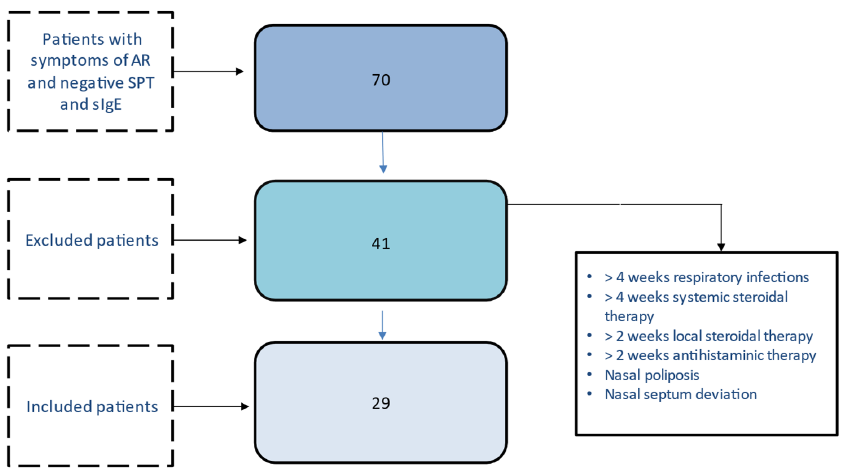
Figure 1. Flow-chart of the study.